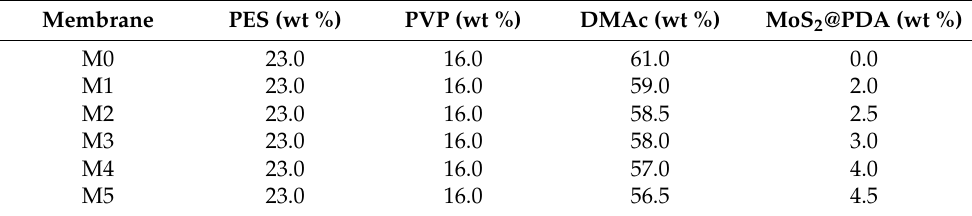
Table 1. The composition of casting solutions for MoS 2 @PDA/polyethersulfone (PES) tight ultrafil- tration (TUF) mixed matrix membranes.